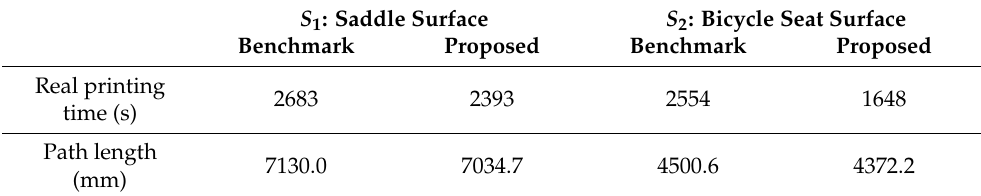
Table 2. Experimental data.